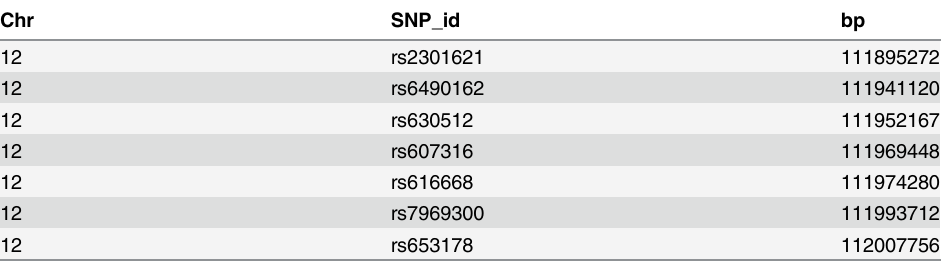
Table 1. Seven SNPs in